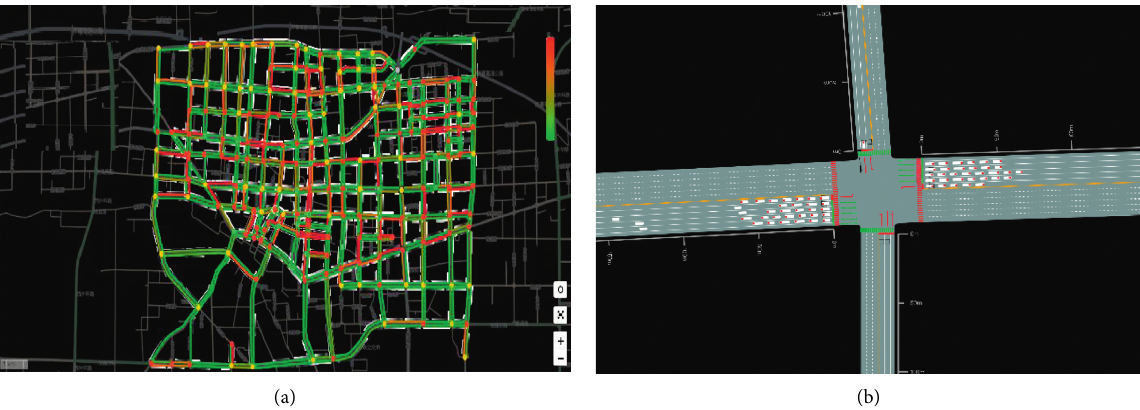
Figure 4: Real-time simulation functional structure design. (a) Simulation of road network. (b) Simulation of intersection.